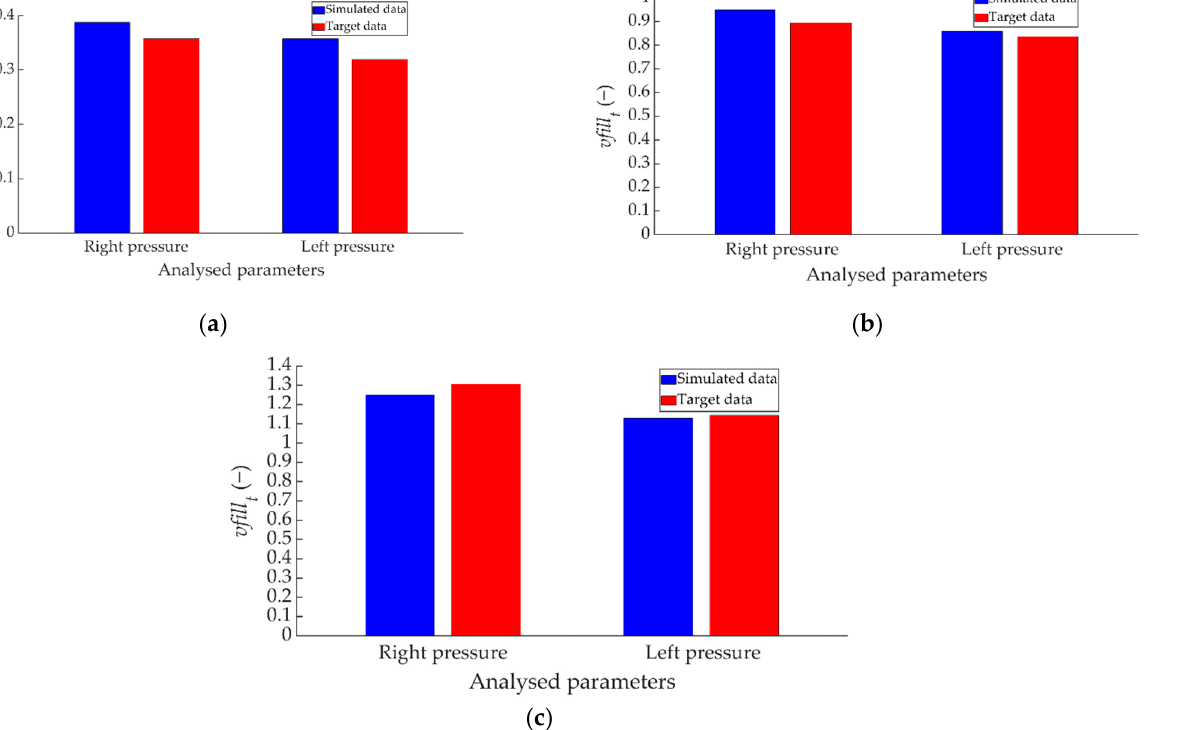
Figure 20. Comparison between the ANN-simulated data and vfill t target data for the two pres- sure sensors for braking at a speed of 70 km/h for the type: ( a ) maintained, ( b ) progressive and ( c )